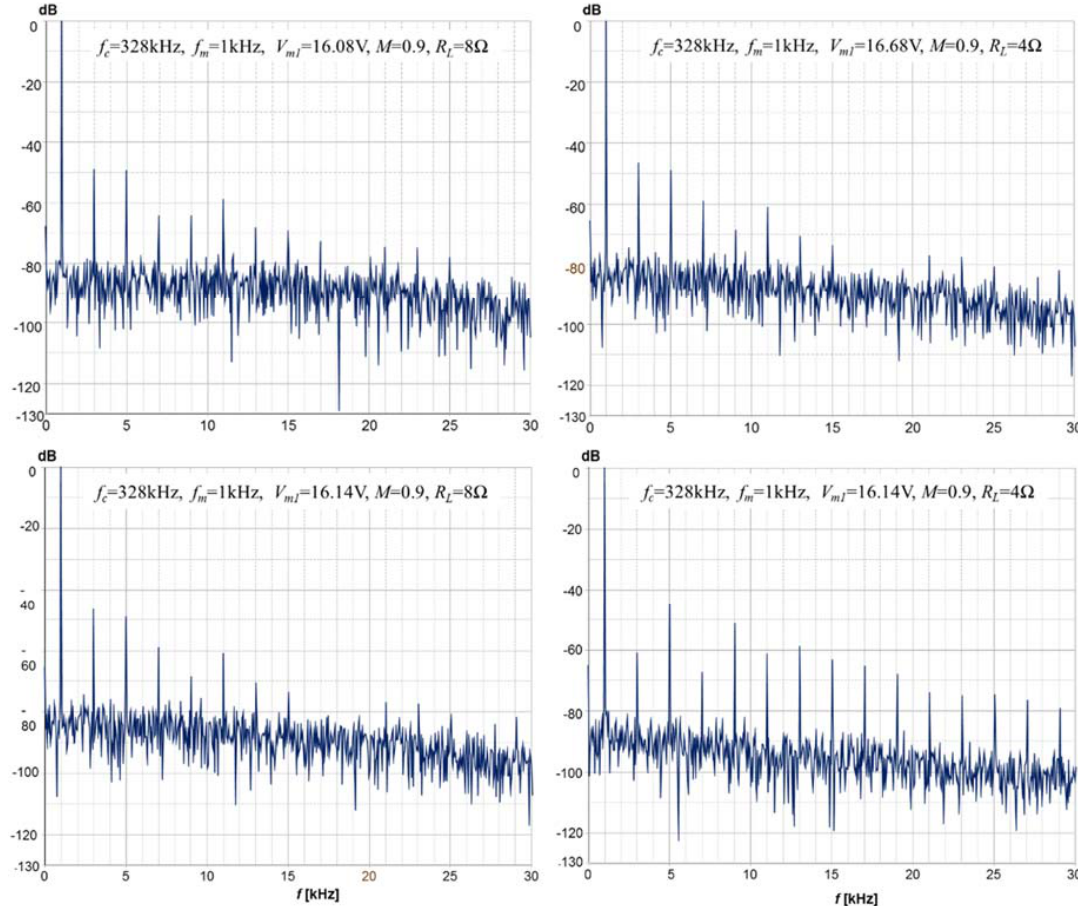
Energies 2021 , 14 , x FOR PEER REVIEW 12 of 17 Figure 10. Simulated THD + N frequency responses of the tested amplifiers in the band up to 30 kHz.